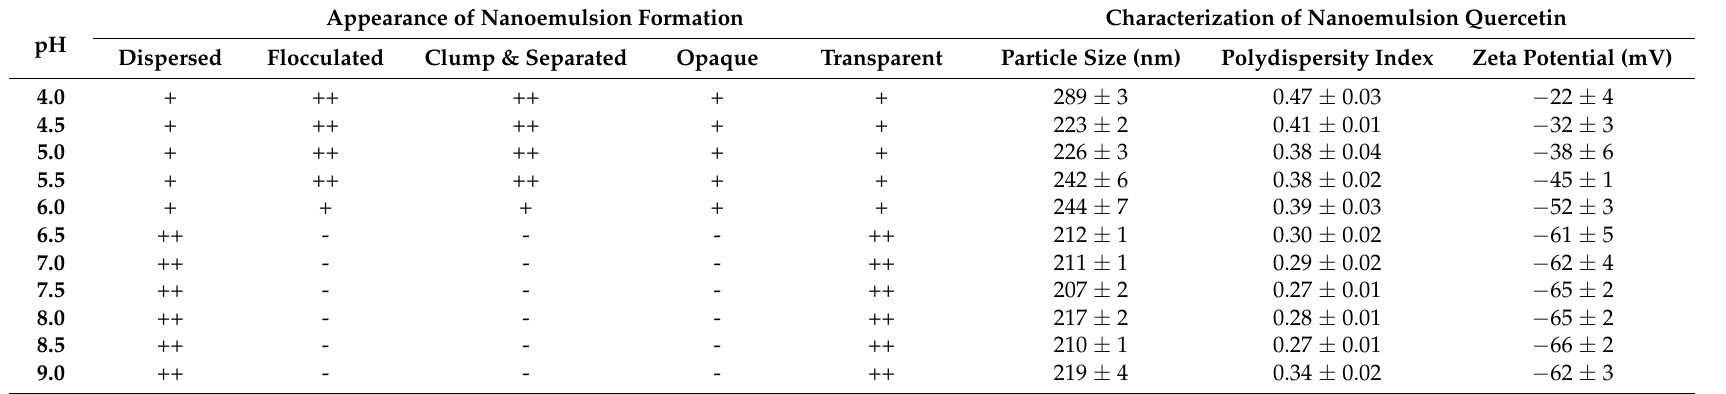
Table 1. Effect of pH on the appearance and characterization of quercetin-loaded oil-in water nanoemulsion.